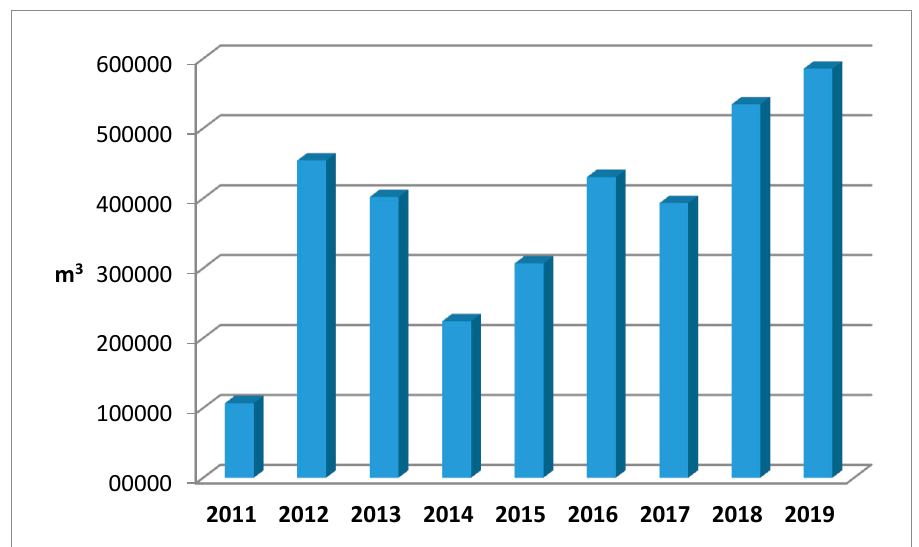
Figure 4. Location of the stormwater infrastructures and green areas watered with treated water. Own elaboration.